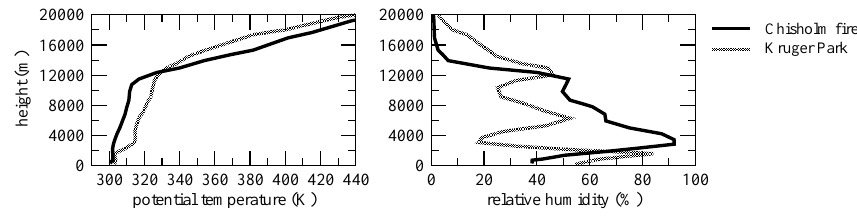
Fig. 3. Meteorological conditions given by ERA40, potential temperature in K and relative humidity in % at two fire locations: 55N/114W the 28 May 2001 at 16:30LT for the Chisholm fire and 25S/31E the 24 September 1992 at 14:00LT for the Kruger fire.